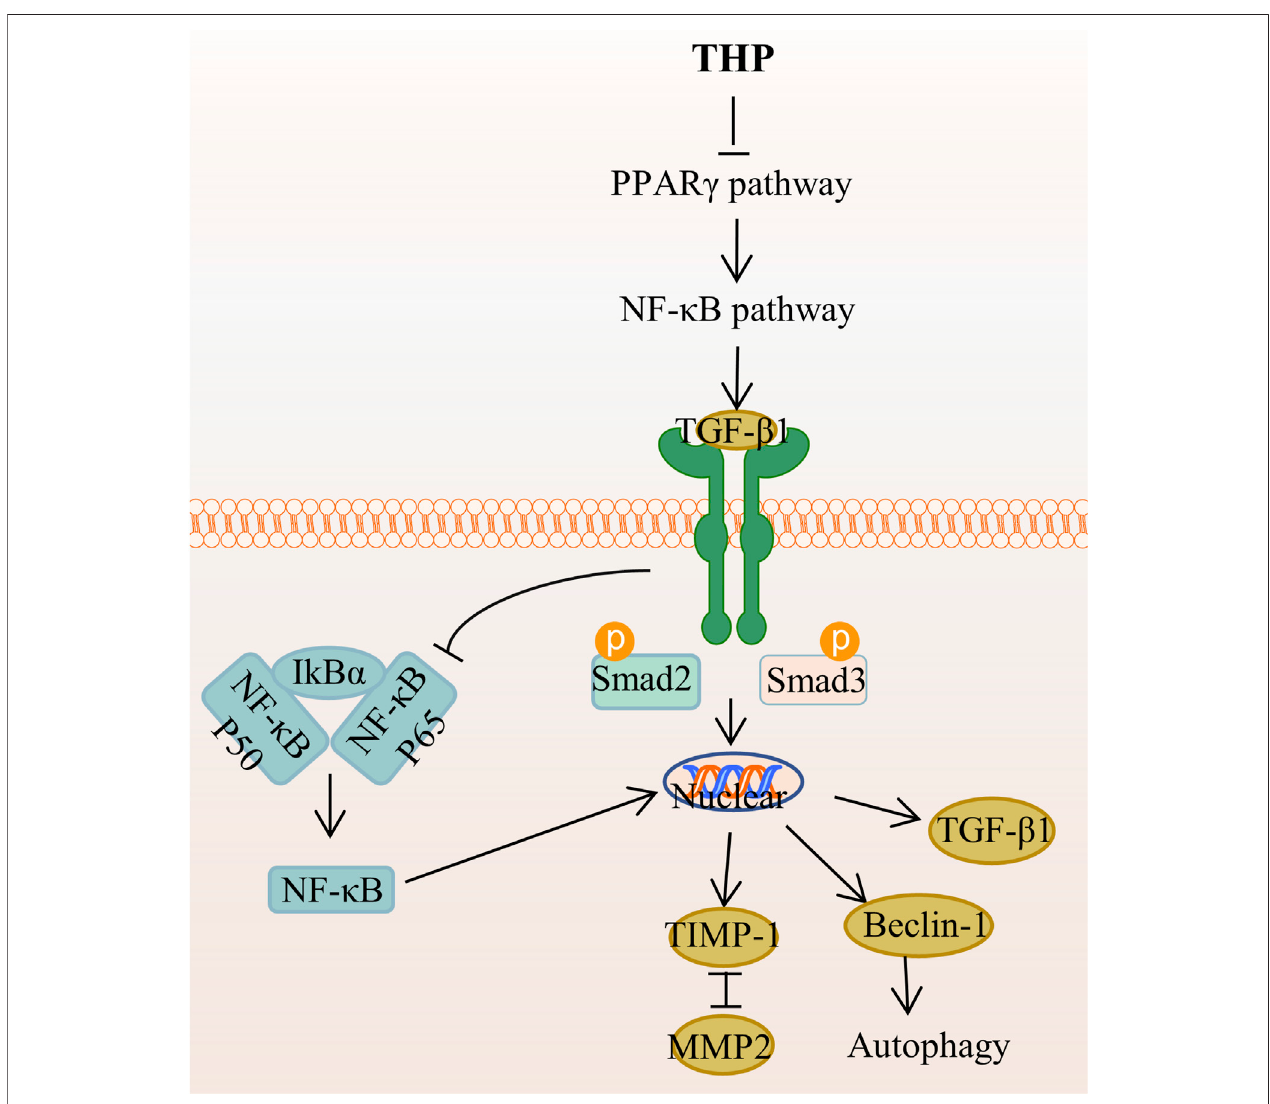
FIGURE 7 | The main targets and pathways of anti-hepatic fi brosis activity of THP. Abbreviations:THP, Tetrahydropalmatine; PPAR γ , Peroxisome proliferator- activated receptor gamma; NF- κ B, Nuclear factor-kappa B; TGF- β 1, Transforming growth factor- β 1; I κ B α , Inhibitor of kappa B alpha; Smad2, Drosophila mothers against decapentaplegic protein 2; Smad3, Drosophila mothers against decapentaplegic protein 3; TIMP-1, Tissue inhibitor of metalloproteinase 1; MMP2, Matrix metalloproteinase 2.